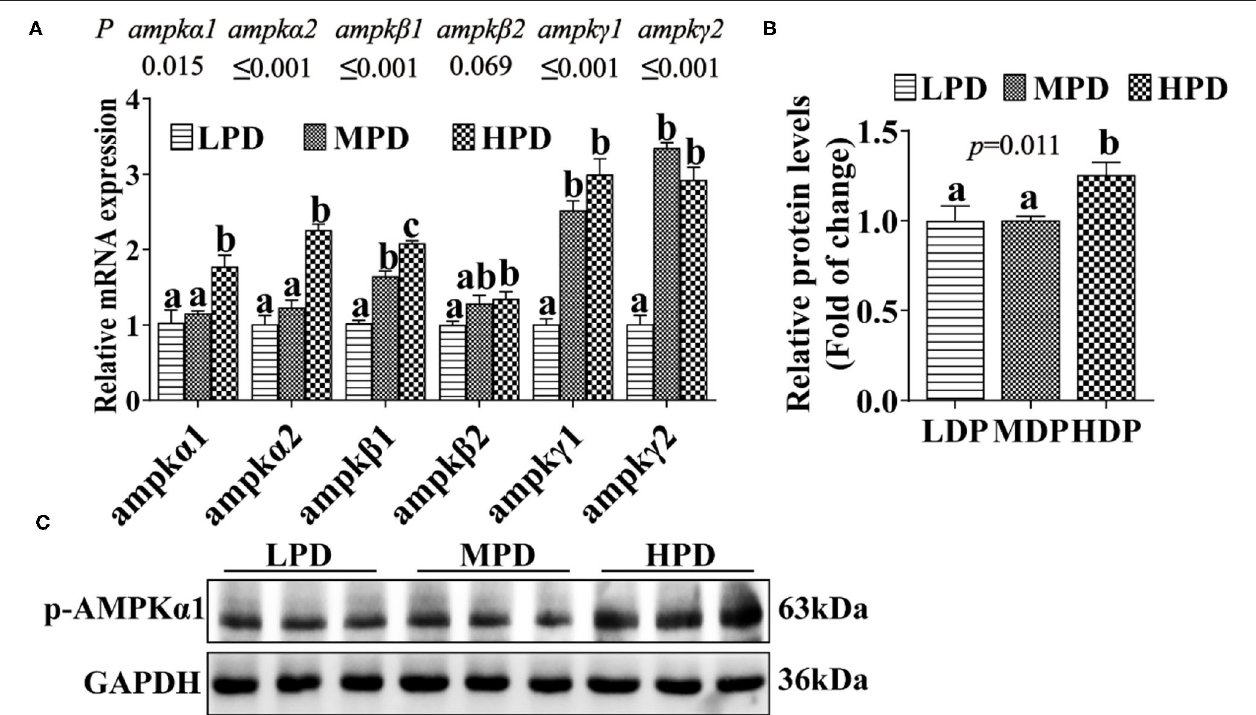
FIGURE 3 | Dietary phosphorus supplementation activated the AMPK pathway and increased AMPK α 1 phosphorylation level in tilapia liver. (A) Relative mRNA levels of genes related to AMPK pathway. (B,C) Western blot analysis of p-AMPK α 1 protein levels. Data are mean ± SEM ( n = 3). “a–c” denote significance at P ≤ 0.05. The P value was calculated by the one-way ANOVA and further the post-hoc Duncan’s multiple range testing.